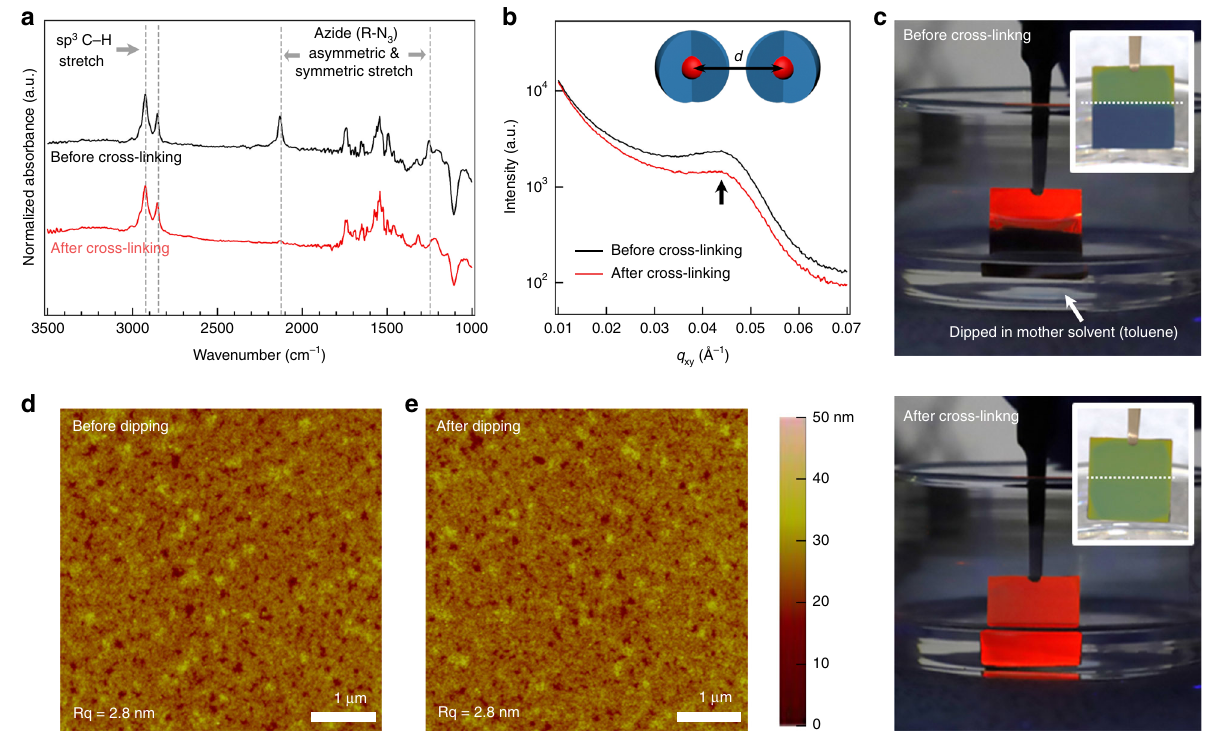
Fig. 2 Characterisation of crosslinked QD fi lms prepared with LiXer. a FT-IR spectra and b GI-SAXS patterns of 13-nm sized CdSe/CdZnS QD fi lms blended with LiXer (5 wt%) before (black) versus after (red) UV exposure (254 nm, 0.4 mW cm − 2 ). The FT-IR spectra were normalised to the maximum absorbance of the sp 3 C – H stretch peak at 2924 cm − 1 and displayed with an offset for easier comparison. c Photographs of a crosslinked QD fi lm with presence of 5 wt% LiXer (bottom) and a pristine QD fi lm (top). Both fi lms were partially dipped into toluene, which is the mother solvent that was used to cast these QD fi lms. AFM images of a crosslinked 13-nm sized CdSe/CdZnS QD fi lm d before and e after being dipped into (Fig. 4c and corresponding PL decay curves in Supplementary Fig. 8). QD fi lms with the optimum content of LiXer retain their